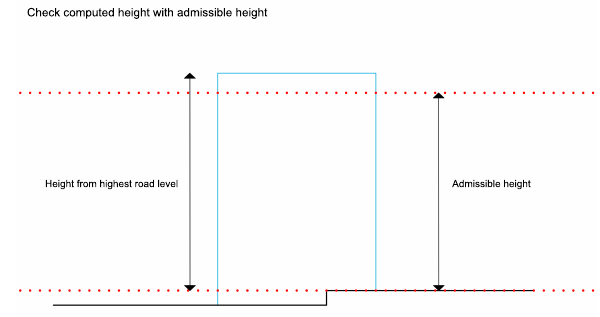
Figure 1. Steps to automatically check whether the building’s GF is within the parcel boundary